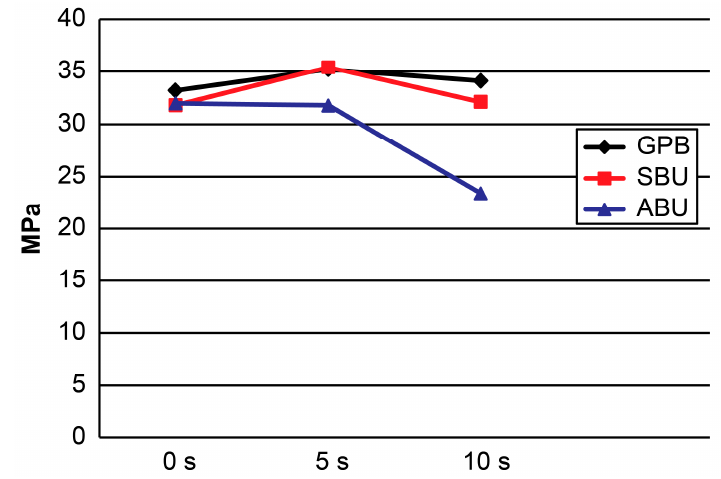
Figure 1. Micro-tensile bond strength ( μ TBS) means obtained in etch-and-rinse mode. GPB: G-Premio Bond; SBU: Single Bond Universal; ABU: All Bond Universal.